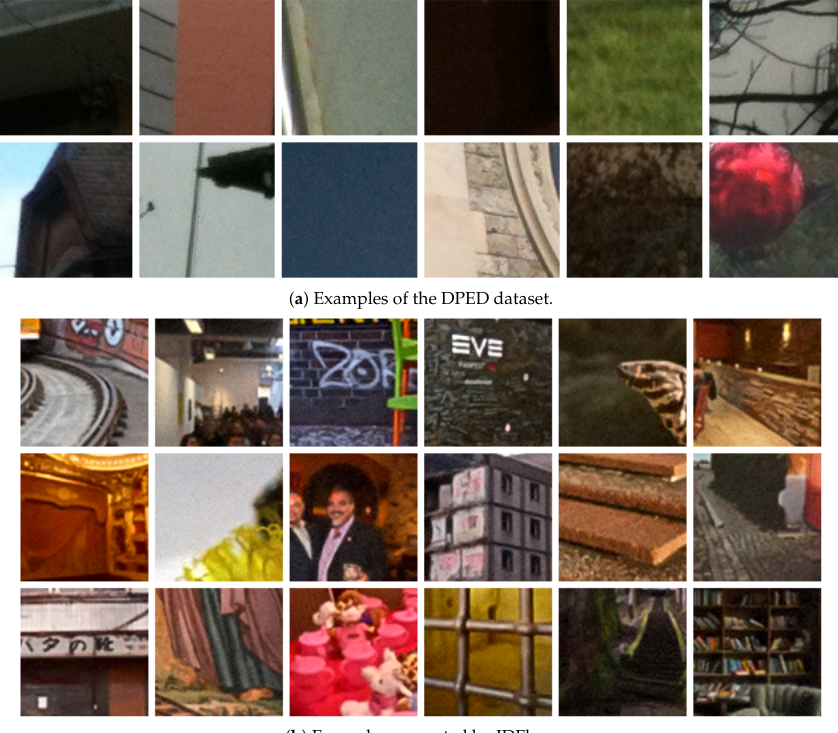
Figure 7. Examples of realistic noisy image patches generated by IDFlow. The images in ( a ) and ( b ) have similarly noisy visual